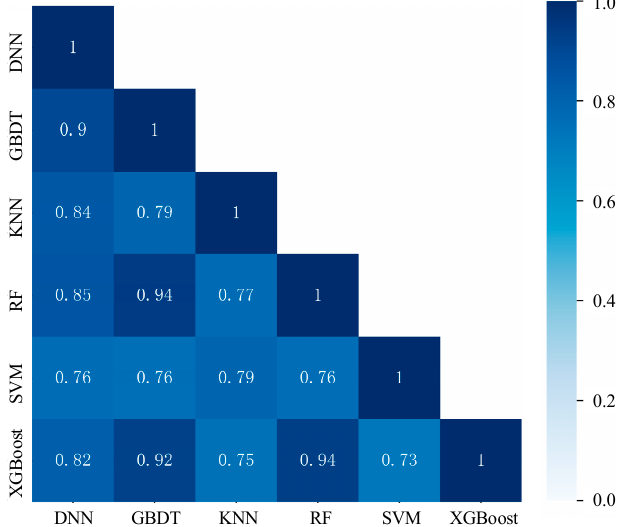
Figure 6. Comparison of prediction error correlations for each single model.